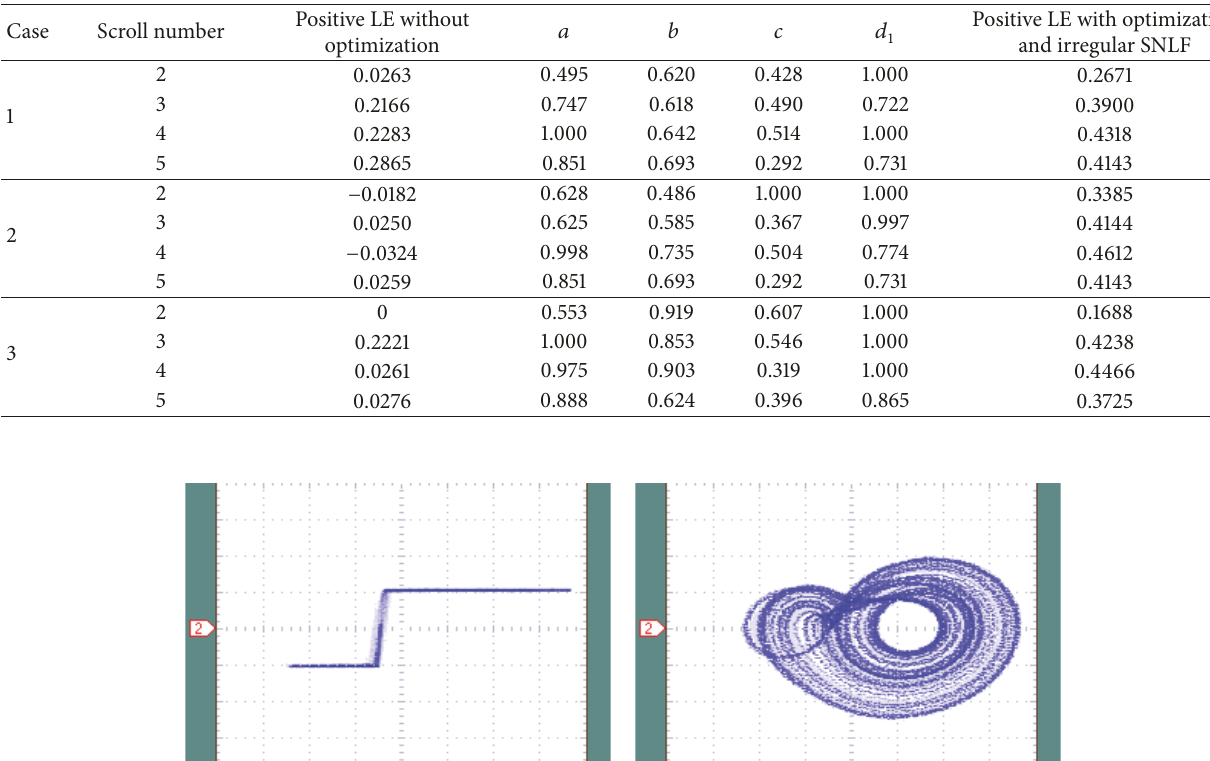
Table 6: Positive LEs for the optimized multiscrolls chaotic oscillators with different delays ℎ as the cases listed in Table 5.